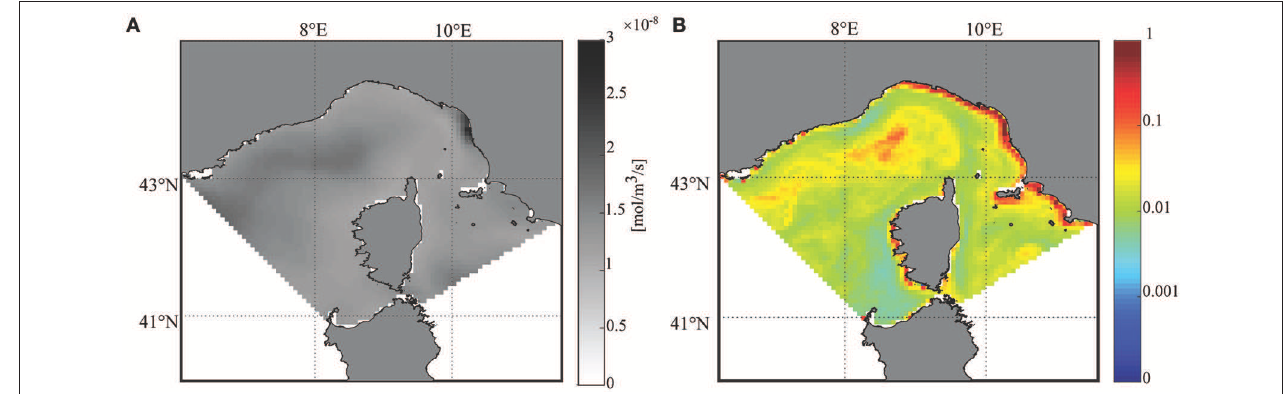
FIGURE 6 | An application of our methodology to a different ecological target: maps of exposure to plastic pollution and of the related risk for the whole marine ecosystem of the Pelagos Sanctuary during summer months. (A) Average NPP in 2000–2010, as derived from Teruzzi et al. (2016), used to assess the exposure component for the marine ecosystem. (B) Average risk caused by plastic